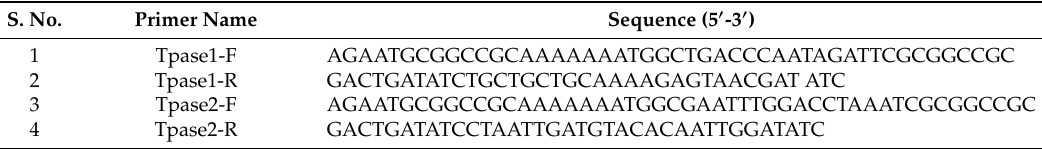
transposases. Table4. Thedetailed sequencesofprimers usedinthe studytoamplify Ppmar1 and Ppmar2 transposases. S.